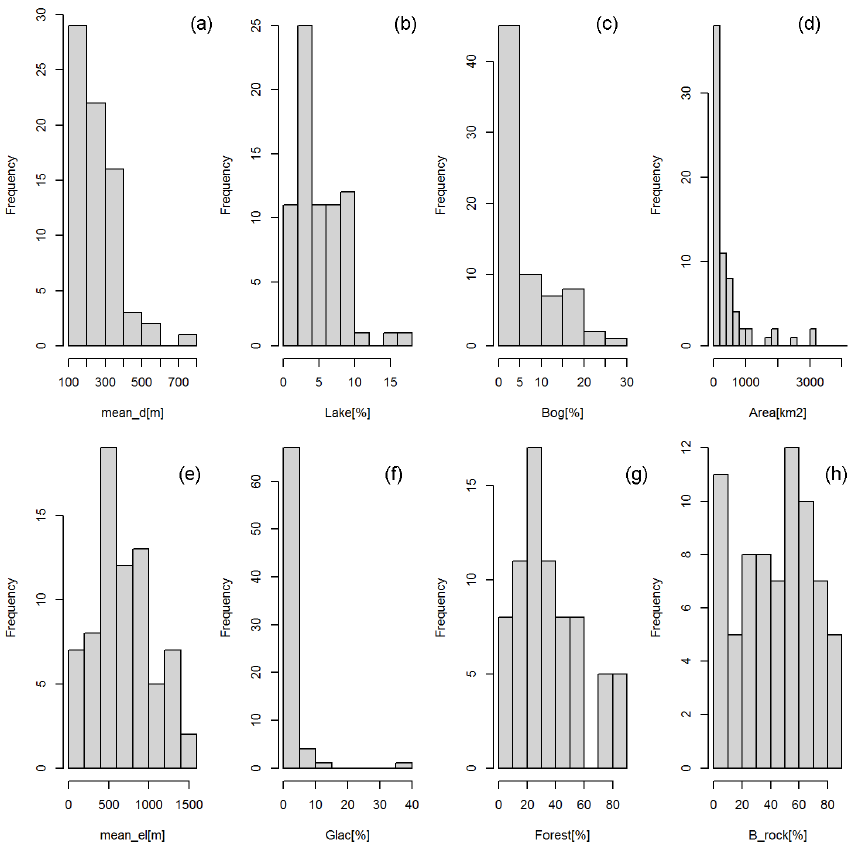
Figure 6. Histograms of catchment characteristics for the 73 catchments. (a) Mean of the hillslope distance distribution, d , (b) areal per- centage of lakes, (c) areal percentage of bogs, (d) catchment area, (e) mean elevation, (f) areal percentage of glaciers, (g) areal percentage of forests and (h) areal percentage of bare